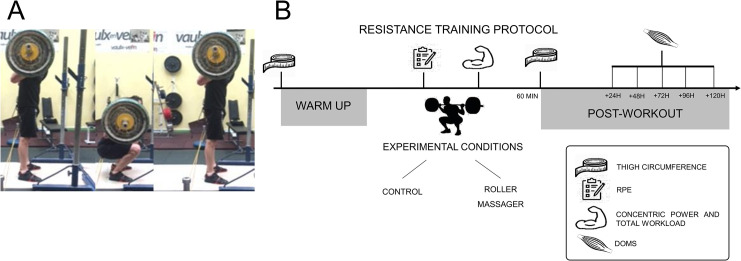
Back squat movement.A. Execution stages of the back squat. B. Flowchart summarizing the experimental protocol.